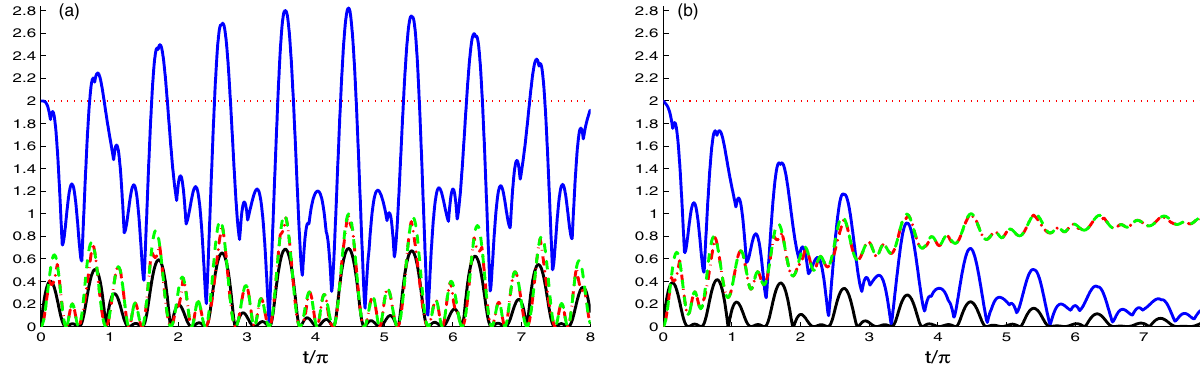
Figure 7. As Fig. 6 but for the competition case J